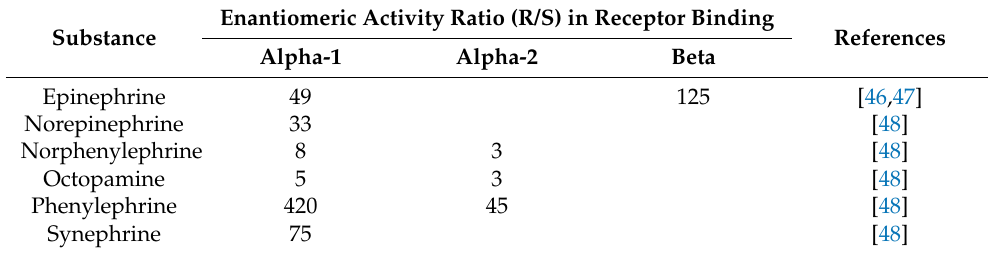
Table 2. Stereoselectivity in adrenoreceptor binding by phenylethylamines investigated